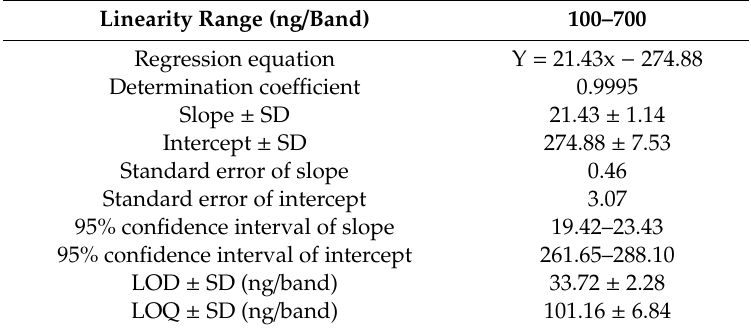
Table 2. Linear regression data for the calibration curve of DIOM (mean ± SD; n = 6).